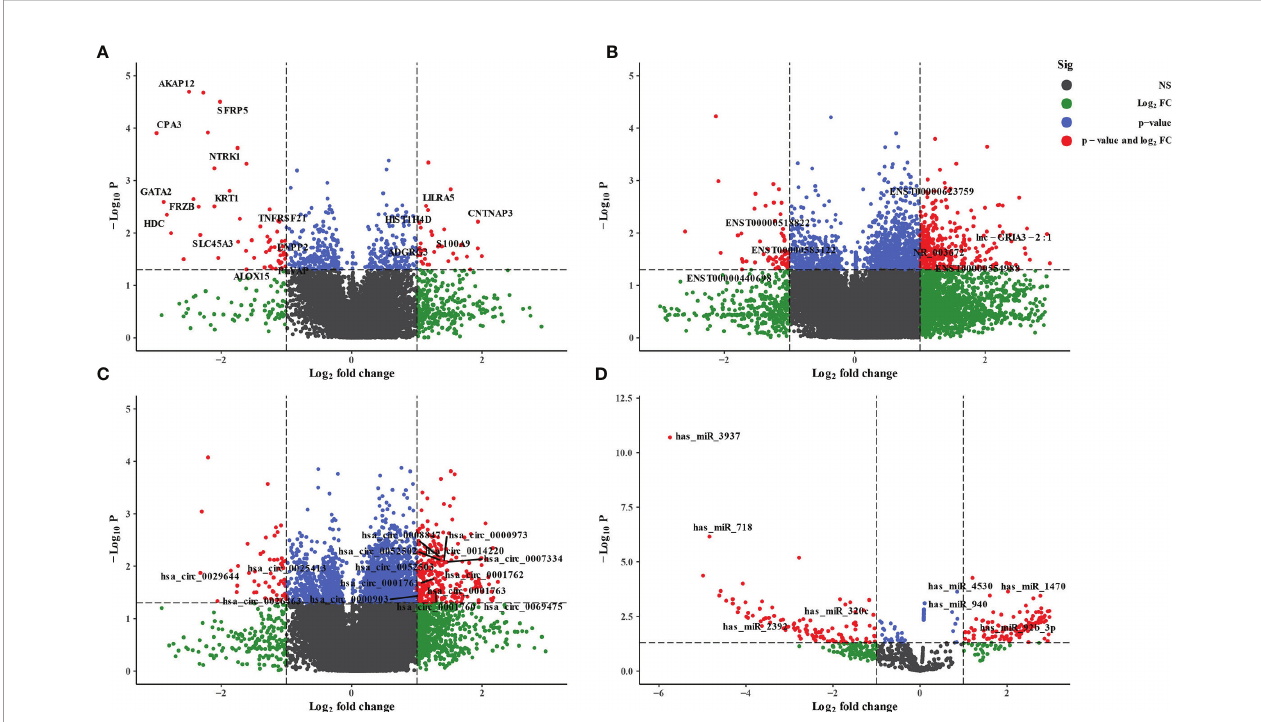
FIGURE 2 | Volcano plot of differentially expressed RNAs between depression patients and health volunteers. |log2(fold change)| >1, false-discovery rate (FDR) <0.05. (A) mRNAs, (B) lncRNAs, (C) circRNAs, and (D) miRNAs. Red points with log2(fold change) < − 1 represent downregulated RNAs, while red points with log2(fold change) >1 represent upregulated